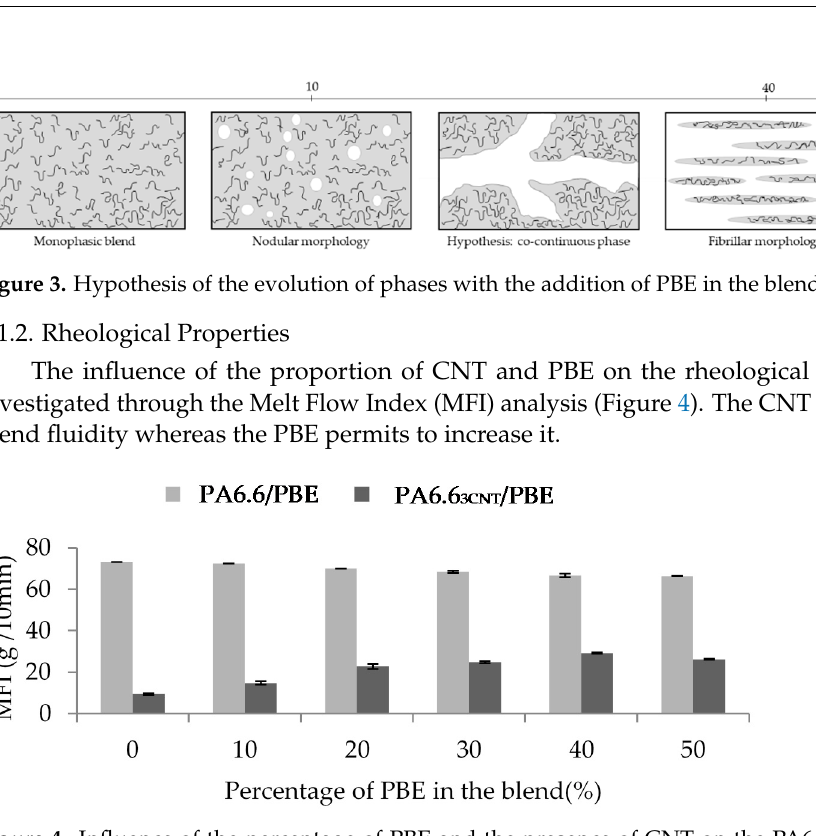
Figure 2. TEM images of PA6.6 3CNT ( a ) and SEM (left)/TEM (right) images of PA6.6 3CNT 90/PBE10 ( b , c ) PA6.6 3CNT 60/PBE40 ( d , e ) blends.